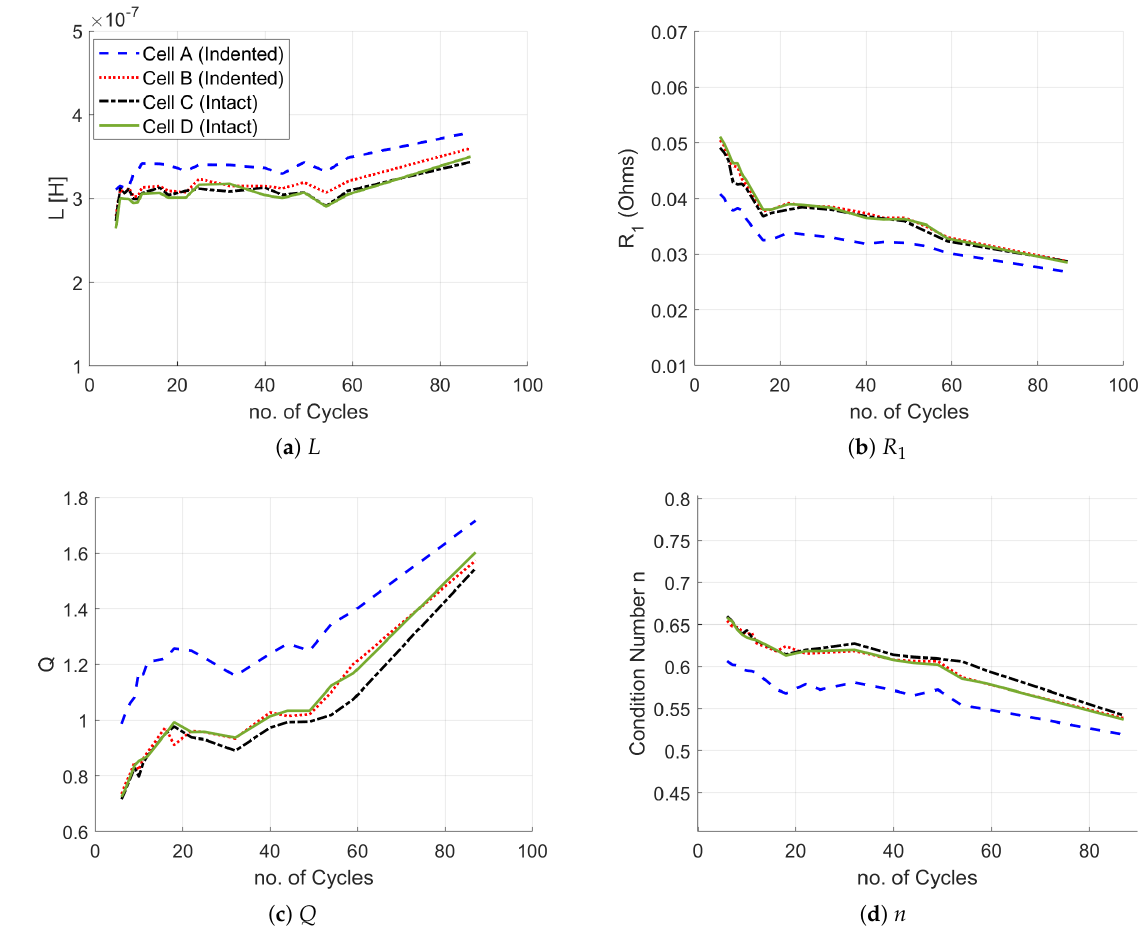
Figure 5. Trend of changes in parameters for all cells with cycling, ( a ) L , ( b ) R 1 , ( c ) Q , ( d ) n ,